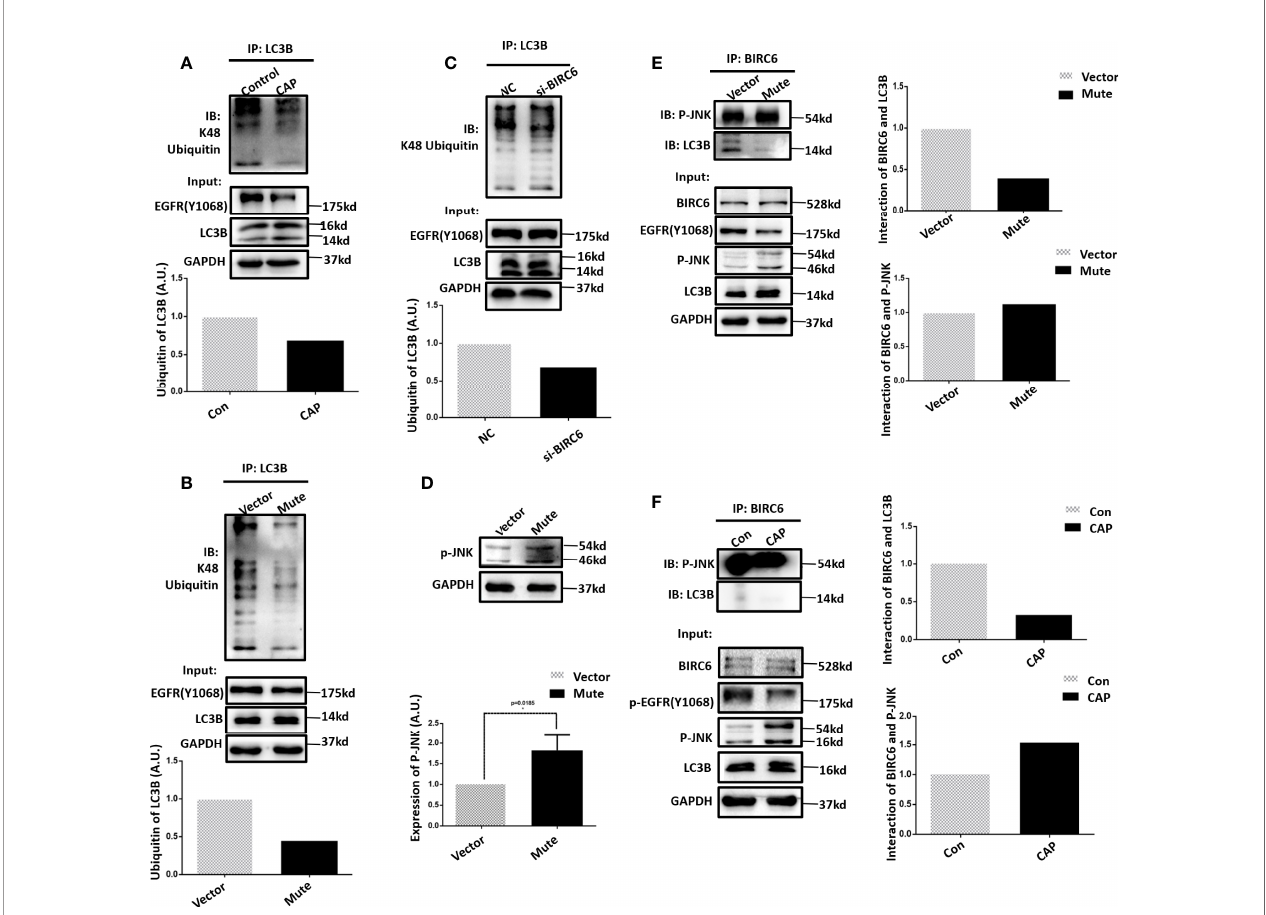
FIGURE 4 | EGFR (Tyr1068) phosphorylation affects LC3B ubiquitination. (A) Immunoprecipitation and its quanti fi cation showing LC3B K48 ubiquitination with and without CAP treatment. (B) Immunoprecipitation and its quanti fi cation showing LC3B K48 ubiquitination with and without EGFR(Tyr1068) mutation. (C) Immunoprecipitation and its quanti fi cation showing LC3B K48 ubiquitination with and without silencing BIRC6. ‘ NC ’ refers to cells transfected with control siRNA. (D) Western blot and quanti fi cation showing the level of phosphorylated JNK (p-JNK). (E) Immunoprecipitation and its quanti fi cation showing interactions between p-JNK and BIRC6, LC3B, and BIRC6 with and without EGFR(Tyr1068) mutation. Quanti fi cations were made from triplicates. ( F ) Immunoprecipitation and its quanti fi cation showing interactions between p-JNK and BIRC6, LC3B, and BIRC6, receiving or not receiving CAP treatment. *: statistical signi fi